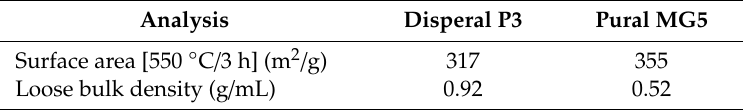
Table 2. Physical characteristics of dispersal P3 and Pural